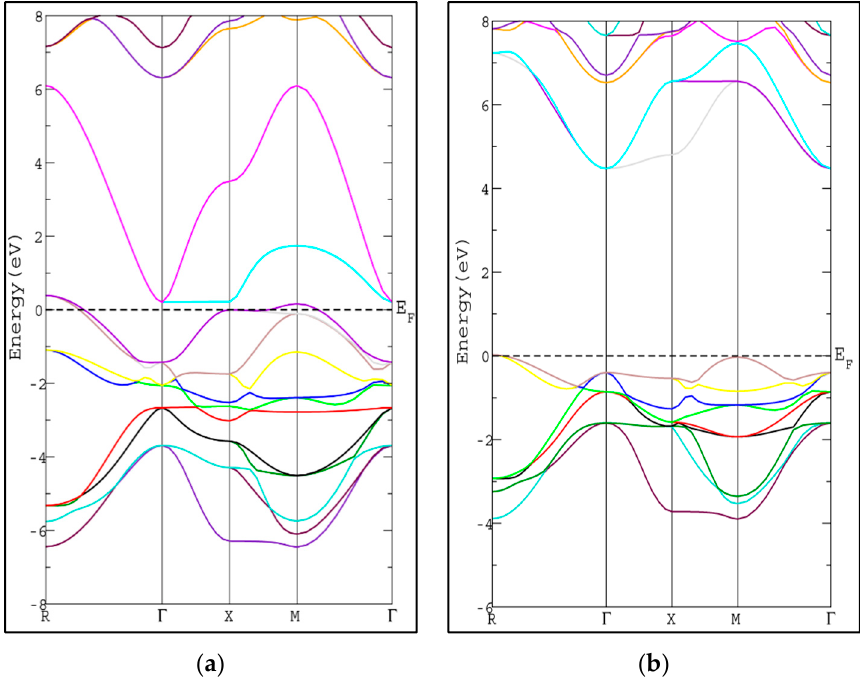
Figure 4. Band structure of cubic pervoskite ( a ) SrRhO 3 and ( b ) SrZrO 3 by using (mBJ-GGA) method. The total and partial density of states for SrRhO 3 and SrZrO 3 are shown in Figures 5 and 6 for an energy range from − 15 to 14 eV and − 12.5 to 14 eV, respectively. In SrRhO 3 , the valence band originates from O- p and Rh- d states. The maximum contribution of the Rh- d state is near the Fermi level. In the conduction band, the bands are due to the Sr- d with a small contribution from Rh- d , O- p and O- s states. In SrZrO3, the valence band originates from O- p with few contribution from Zr- d , p and Sr- d states. In the conduction band, the bands are due to Zr- d and Sr- d states with a small contribution from O- p states.